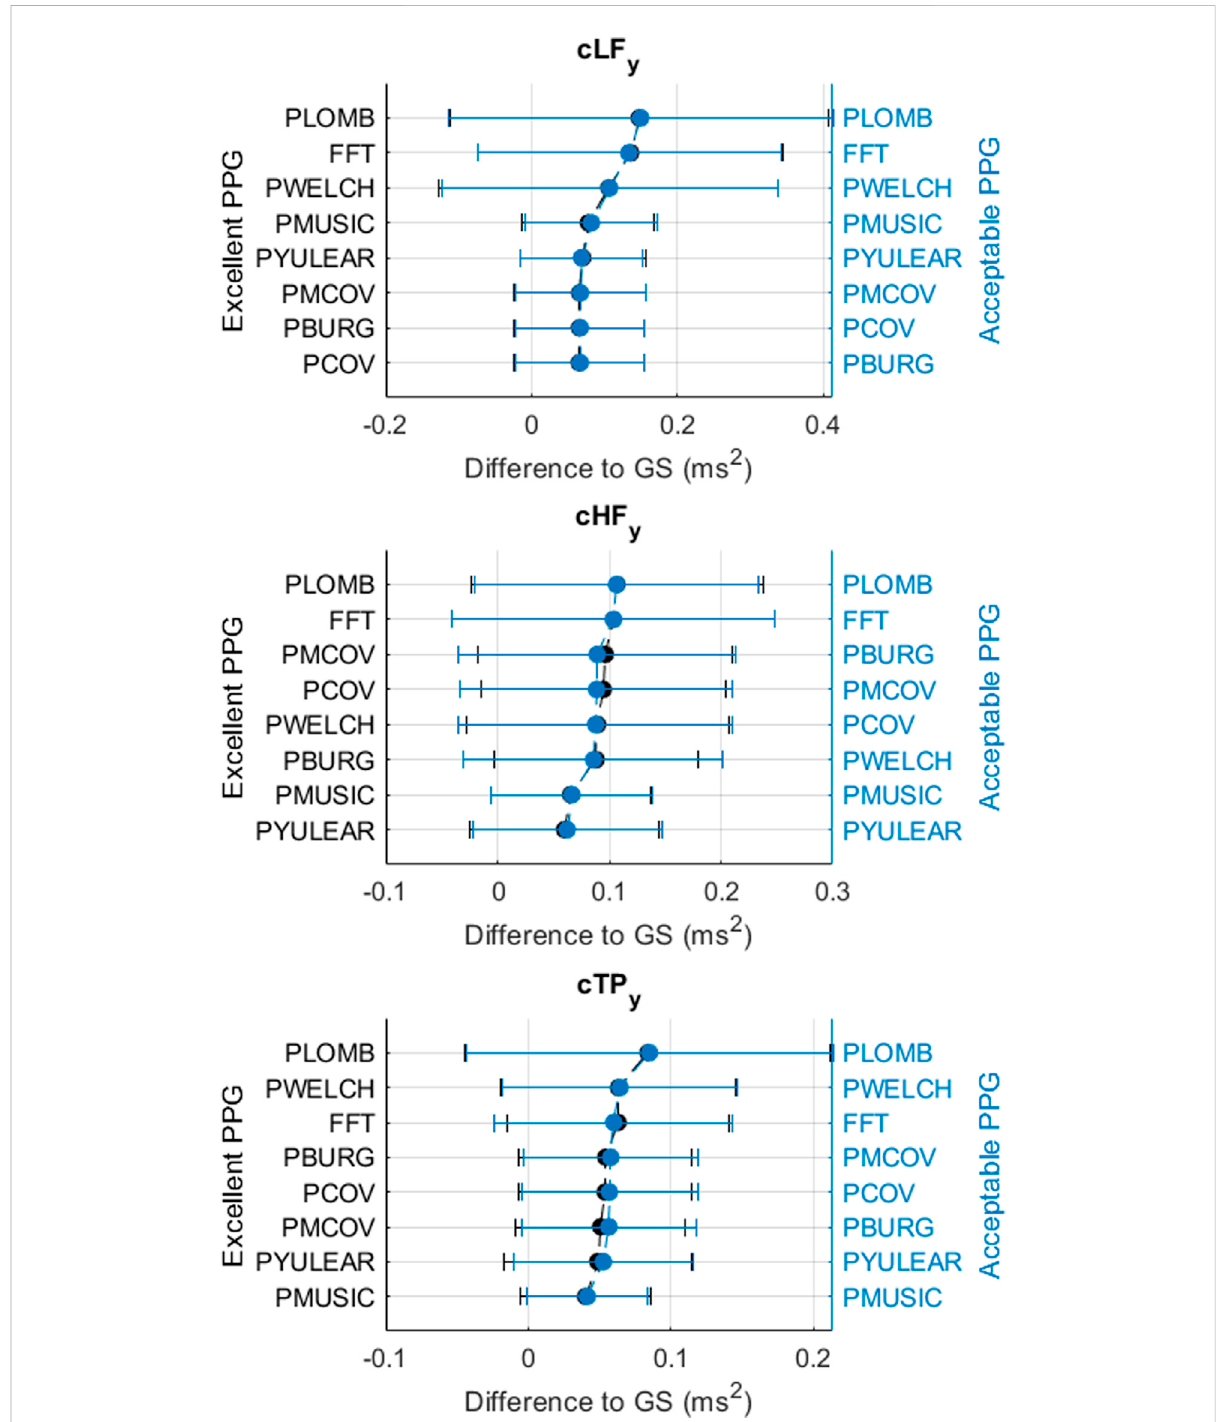
FIGURE 6 Mean and standard deviations of the differences obtained by comparing pulse rate variability y -coordinates of centroid-related frequency- domain indices obtained from extracted and gold-standard